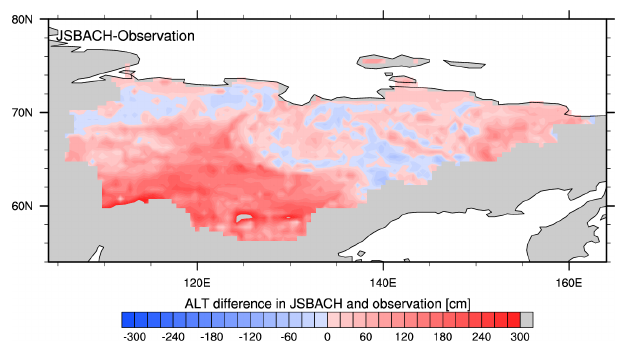
Fig. 15. Simulated and observed annual Lena River runoff. Red line represents the JSBACH model version with the permafrost repre- sentation. The black line shows the observed values from the R- ArcticNet database (Lammers et al., 2001).